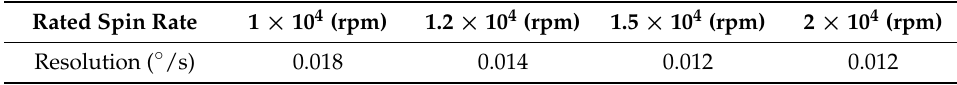
Table 3. Measured resolution of the MESG at different spin rates [20].